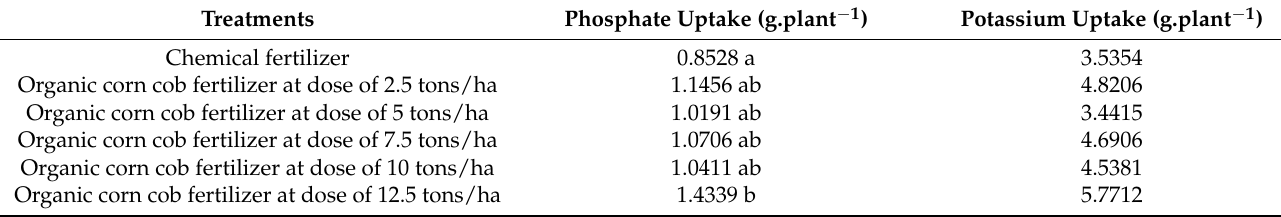
Table 5. The role of corn cob compost dose on phosphate and potassium uptake. Treatments